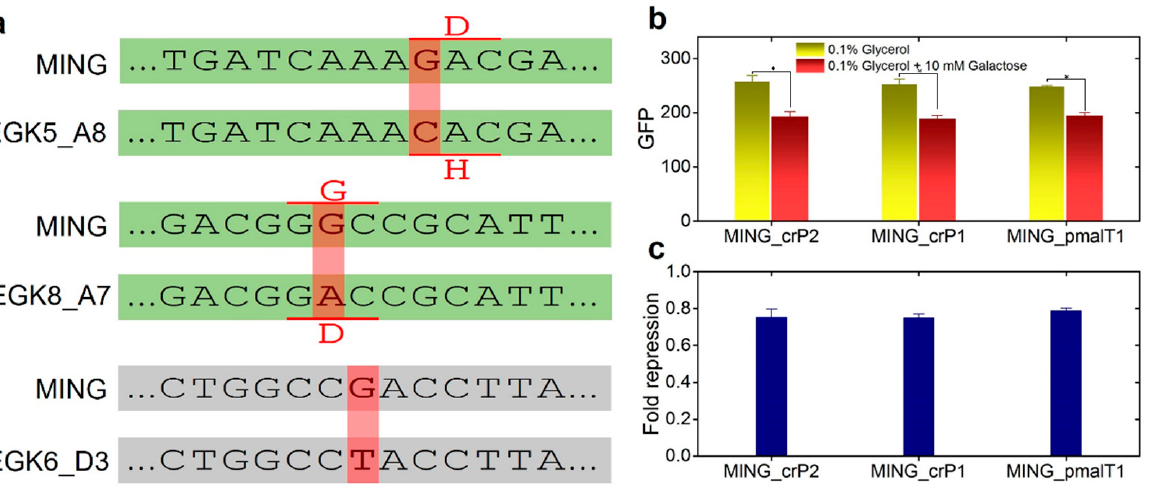
Figure 4. Identification of mutations and characterization of repair mutants. ( a ) Mutations in strains demonstrating the upregulation of malP expression in D-galactose supplemented media. EGK5_A8 and EGK8_A7 had point mutations in the coding region of crP , while EGK6_D3 had a point mutation in the promoter region of the malt gene; ( b , c ) Responses of repair mutants in 0.1% glycerol M9 and 0.1% glycerol M9 supplemented with 10 mM D-galactose. Fold repression was calculated by dividing the gfp ( malP ) levels in 0.1% glycerol M9 supplemented with 10 mM D-galactose with the gfp ( malP ) levels in 0.1% glycerol M9. Point mutations in EGK5_A8, EGK8_A7 and EG6_D3 were repaired to generate the repair mutants MING_crP2, MING_crP1 and MING_pmalT1, respectively. * indicates significant differences ( p -value < 0.05). The p values were calculated by the two-sample t-test. Error bars indicate the standard error of the mean (±).